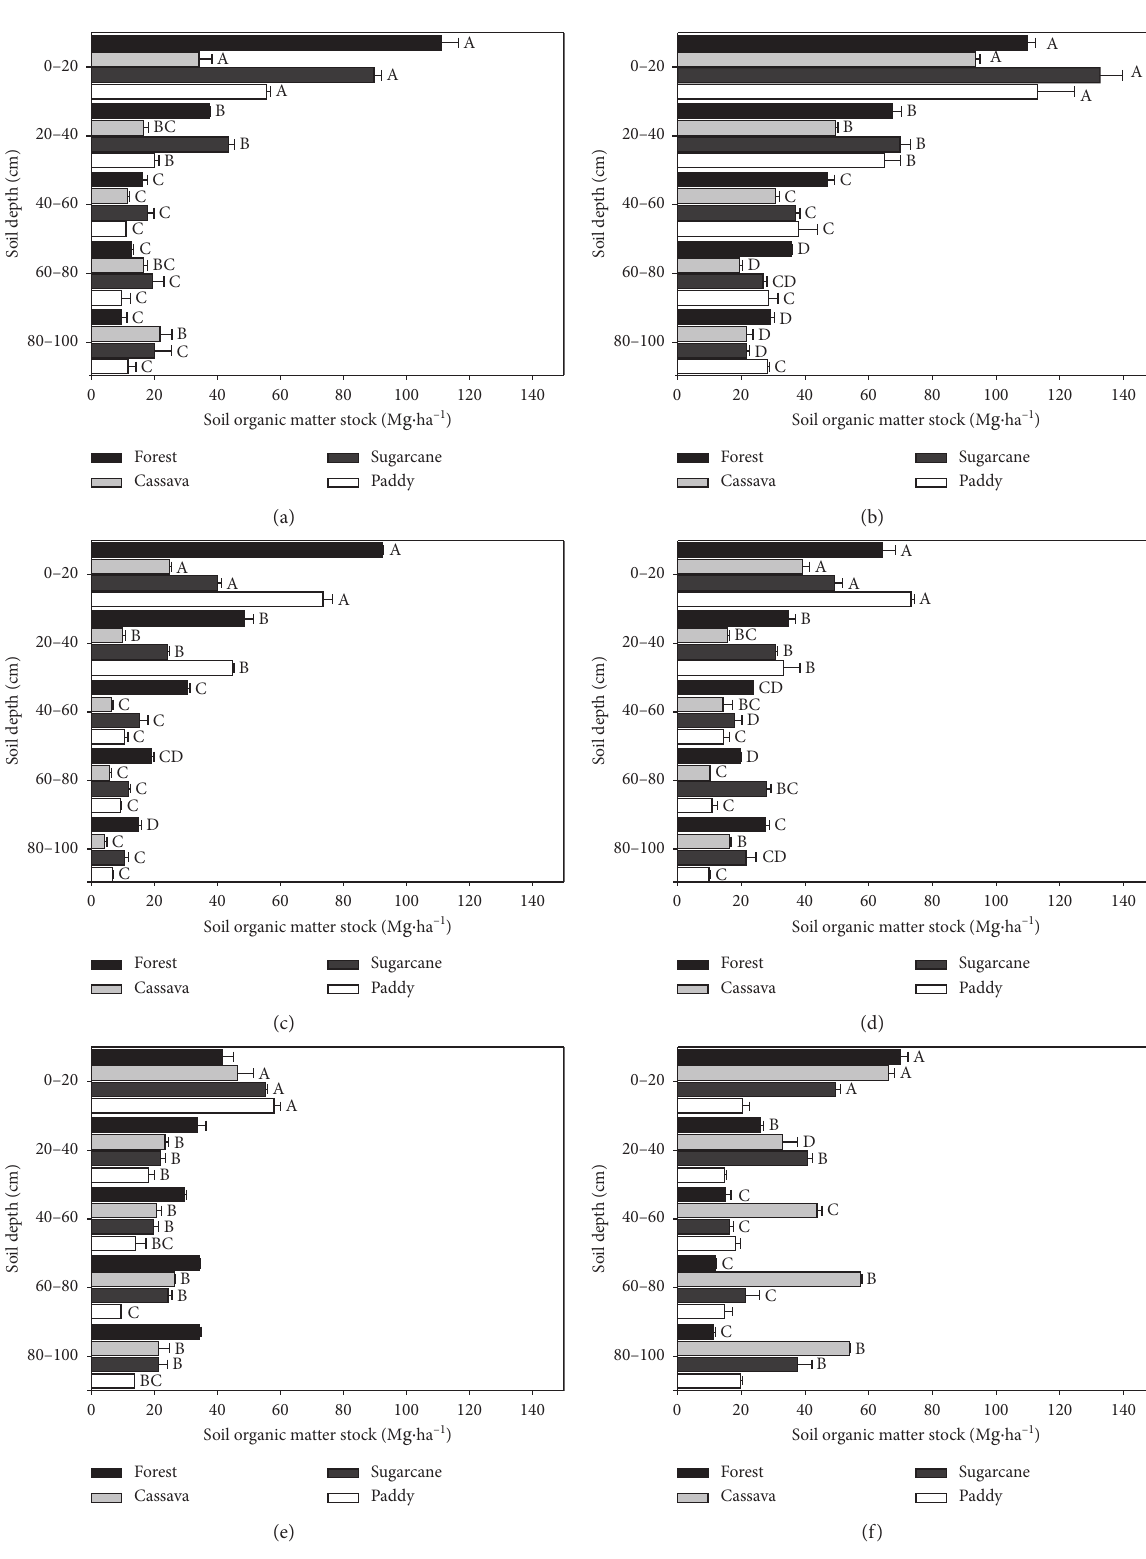
Figure 5: Land use changes affecting distribution of SOM stock in soil profile in six locations. Uppercase letters accompanying bar graphs denote comparisons of SOM stocks among different soil depths within a land use type. Similar letters indicate no significant differences ( P > 0 . 05), as analysed by the LSD method. Error bars represent standard error of the mean. (a) Muang. (b) Kantharawichai. (c) Kosum Phisai. (d) Kut Rang. (e) Borabue. (f) Wapi